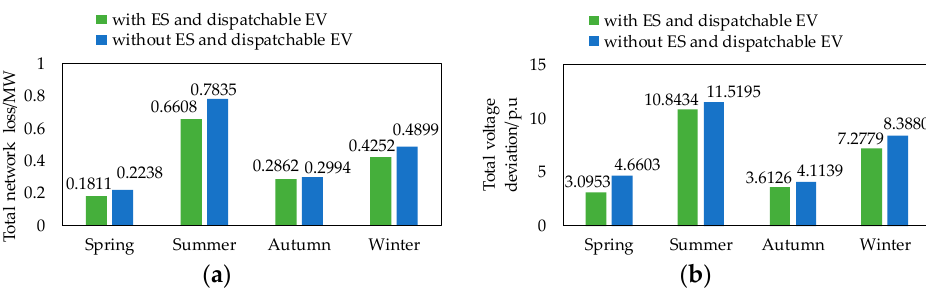
Figure 7. Comparison of results with and without ES and dispatchable EV in multiple scenarios. ( a ) Total network loss. ( b ) Total voltage deviation. Table 1. The percentage of decrease in total network loss and voltage deviation after dispatching of ES and EV.